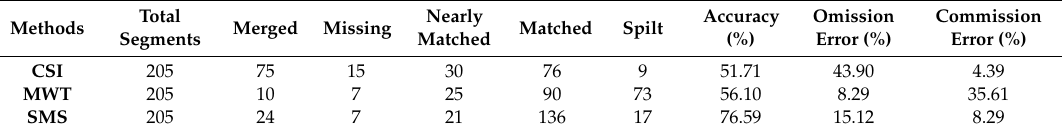
Figure 9. The tree crown maps of the rainforest plot obtained by the traditional watershed segmentation ( a ), the Crown Slices from Imagery (CSI) ( b ), commonly used marker-controlled watershed segmentation (MWT) ( c ), and the proposed spectral and multi-scale features (SMS) ( d ) methods, respectively. Table 1. The accuracy statistics of the tree crown maps of the rainforest plot generated by the Crown Slices from Imagery (CSI), the commonly used marker-controlled watershed segmentation (MWT), and the proposed method (SMS) with reference to the same manually delineated tree crown map.